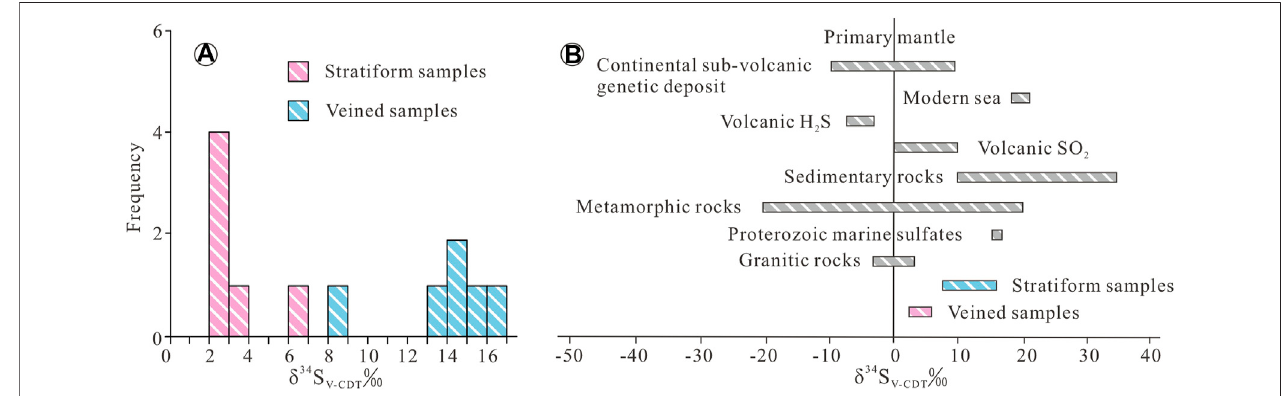
FIGURE 7 | (A) Histogram showing δ 34 S values of the Haerdaban Pb-Zn deposit (B) δ 34 S values from Haerdaban Pb-Zn deposit compared to the values of important geological reservoirs (data from Ohmoto and Rye, 1979; Ohmoto and Goldhaber, 1997; Hoefs, 2009, White, 2013).